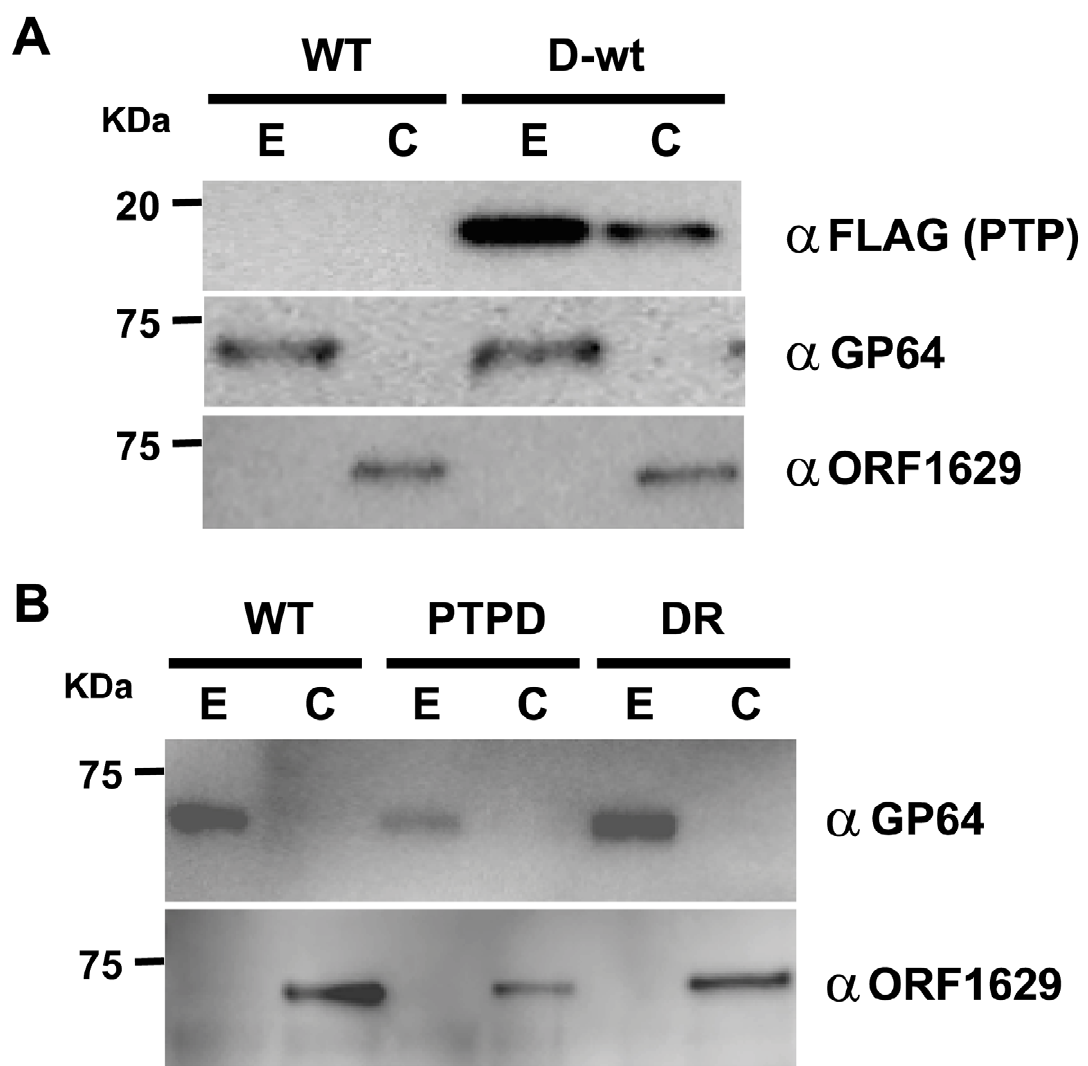
Figure 3. PTP is an envelope-associated protein required for the production of normal virions. (A) Localization of PTP in the envelope and capsid fractions of budded virus. Western blot analysis of envelope (E) and capsid (C) fractions of budded virus (BV) of BmNPV or BmPTPD-wt were performed with anti-FLAG, anti-GP64 or anti-ORF1629 antibodies. (B) Localization of GP64 and ORF1629 in PTP-deficient BV. Western blot analysis of envelope (E) and capsid (C) fractions of BV of BmNPV, BmPTPD, and BmPTPDR were performed with anti-GP64 or anti-ORF1629